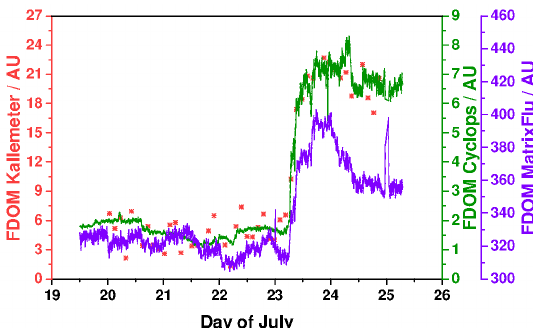
Figure 8. Comparative view on the extracted underway measurements from the MatrixFlu-UV (violet), the FerryBox FDOM Cyclops-7-U sensor (green) and the extracted bulk fluorescence signal from the EEM spectra (red stars), obtained along a transect from the Norwegian coastal sea into the